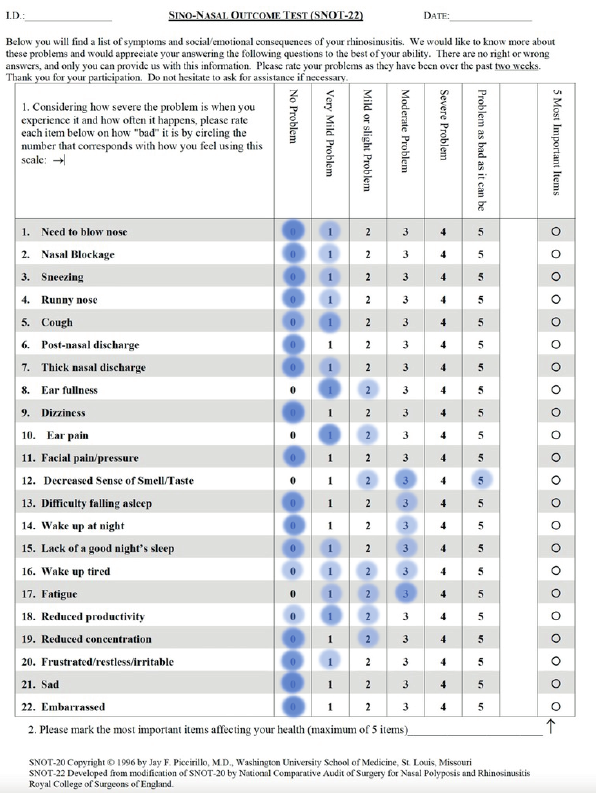
Figure 1. Sino-nasal Outcome Test